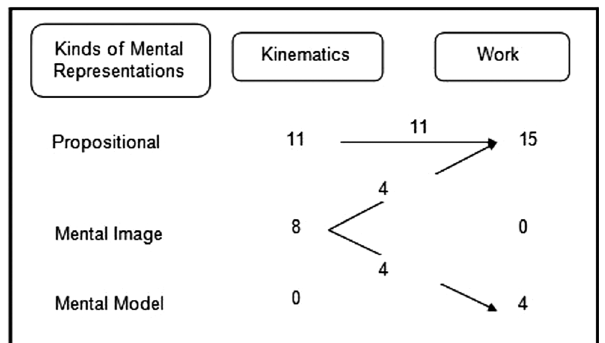
FIG. 24. Categoriesofmentalrepresentationsacrosskinematics and